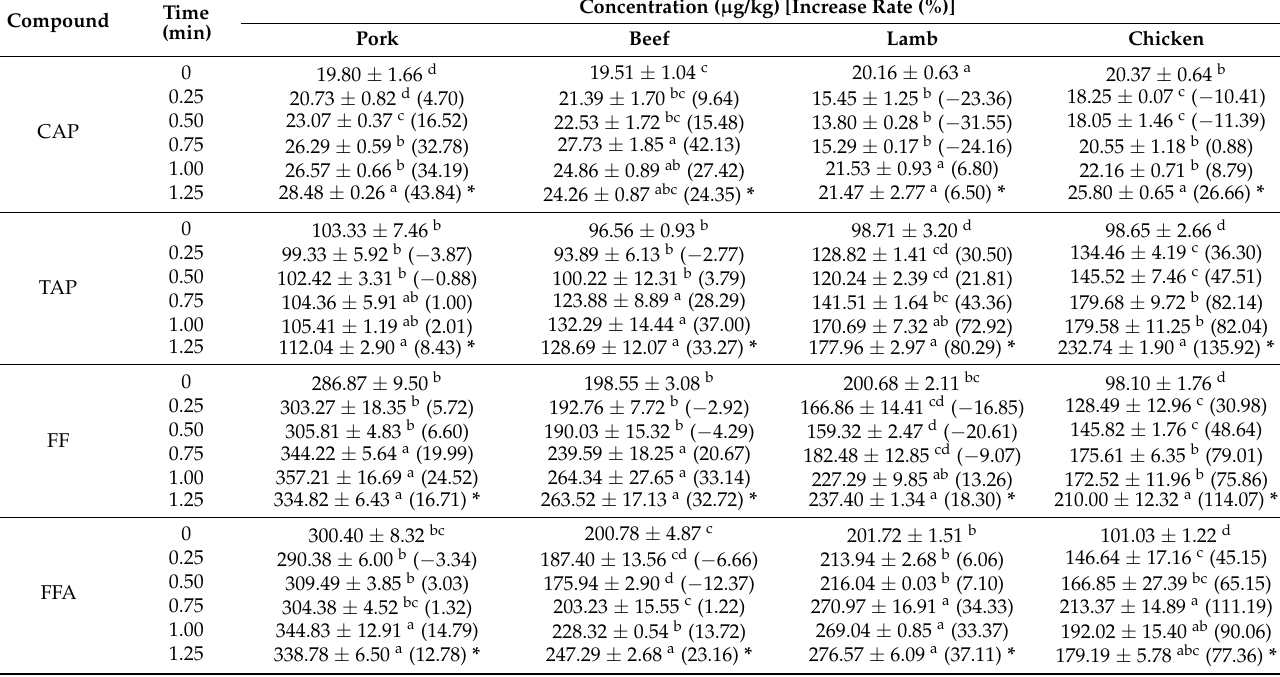
Table 7. Effect of microwave time on residues of amphenicols and metabolites in livestock and poultry